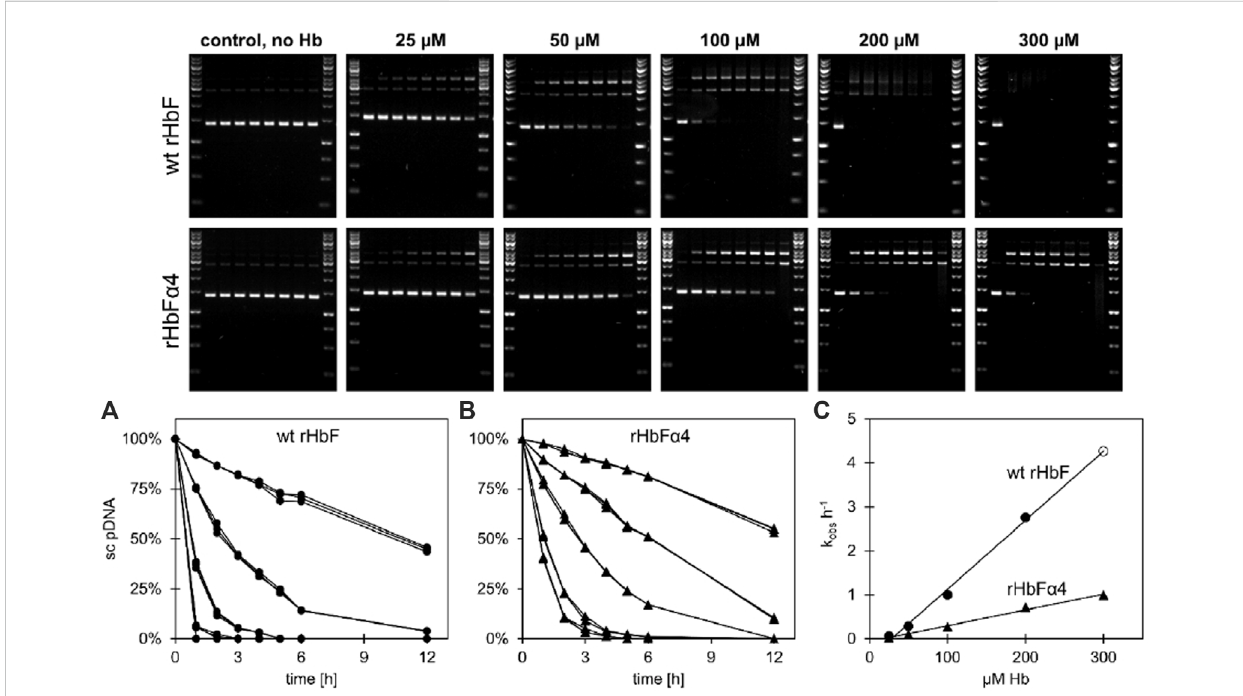
FIGURE 2 Plasmid DNA cleavage of wt HbF and the HbF α 4 mutant was monitored for 12 h at 37 ° C in 20 mM phosphate buffer pH 7.2. Without the addition of Hb, no cleavage of the supercoiled (sc) pDNA was observed. In contrast, when Hb was included, the sc form deteriorated and open circular and linear pDNA bands emerged. Byincreasing theHb concentrations from 0µM to 25, 100, 200and 300 µM (heme) the process wasaccelerated. The decay of sc pDNA over time wasplotted and fi ttedto asingle exponentialequation and thedata for wtHbF andHbF α 4mutantcan beseen ingraphs (A )and (B) , respectively. Circles represent wt HbF and triangles represent HbF α 4mutant. The obtained rateswerethen plotted against theHb concentration and the linearrelationshipwasusedtodeterminethedecayconstantsofpDNAcleavage[graph (C) ].ThedatapointforwtHbFat300 µM(opencircle)ingraph (C) is a product of the linear fi tting to the other wt HbF data points, due to the lack of detection of the sc DNA band after 1 h of incubation.